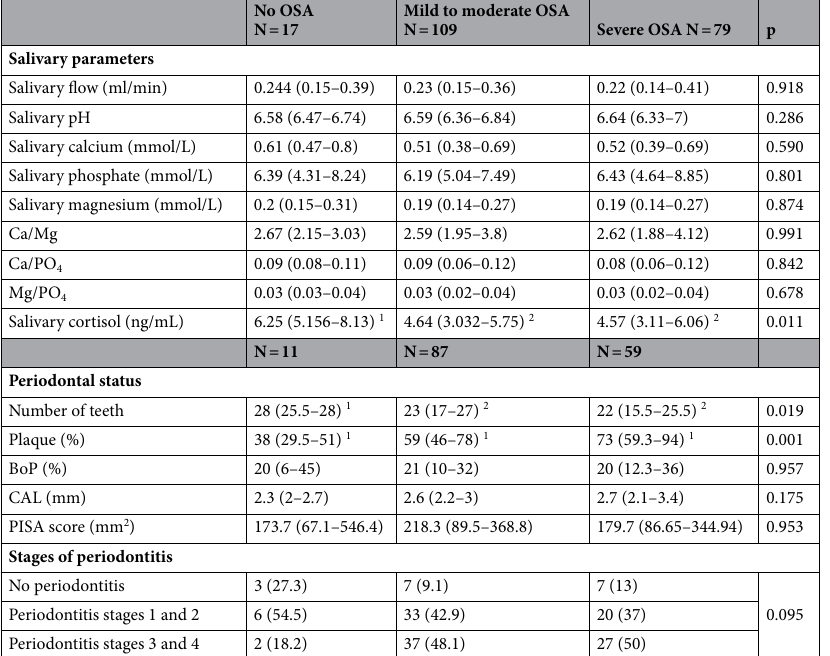
Table 2. Salivary and periodontal parameters according to OSA severity. Data are presented as the medians with interquartile ranges. The Kruskal ‒ Wallis test was calculated for group comparisons. 1 Post hoc difference to both other groups following the Mann ‒ Whitney U test p < 0.05. 2 Post hoc difference only to the no OSA group following the Mann ‒ Whitney U test p <